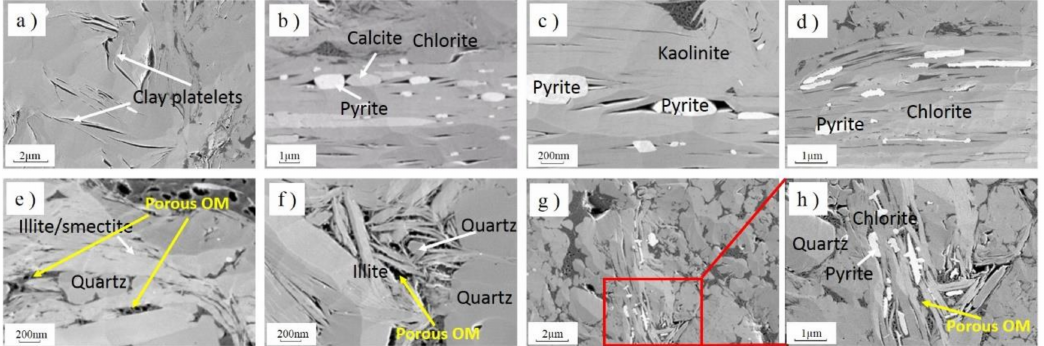
Figure 8. The FIB-SEM 2D images of pores associated with clay mineral flakes: Some minerals are marked by white arrows and porous OM with yellow arrows. ( a – d ) are #2, #4, #5 and #7 samples of the lower Cambrian shale. ( e – h ) are #9, #11 and #15 samples of the lower Silurian shale. Generally, the majority of dissolved pores are related to carbonate minerals (Figure